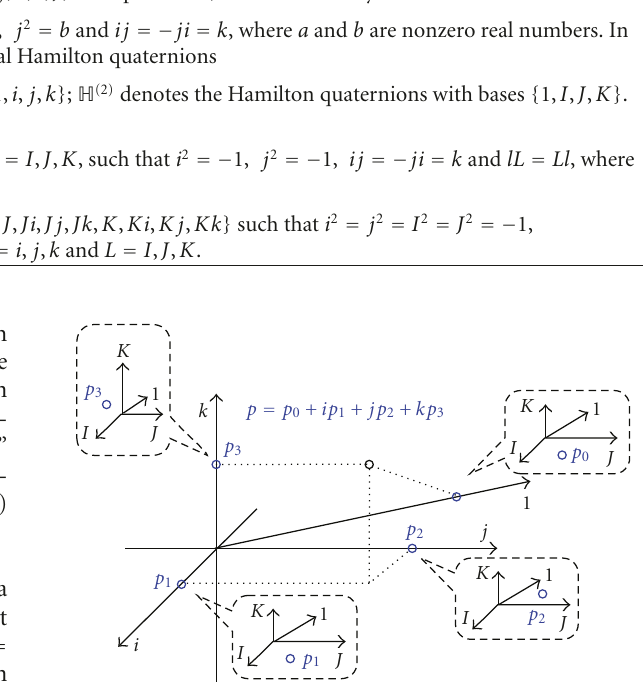
Figure 1: The geometric illustration of